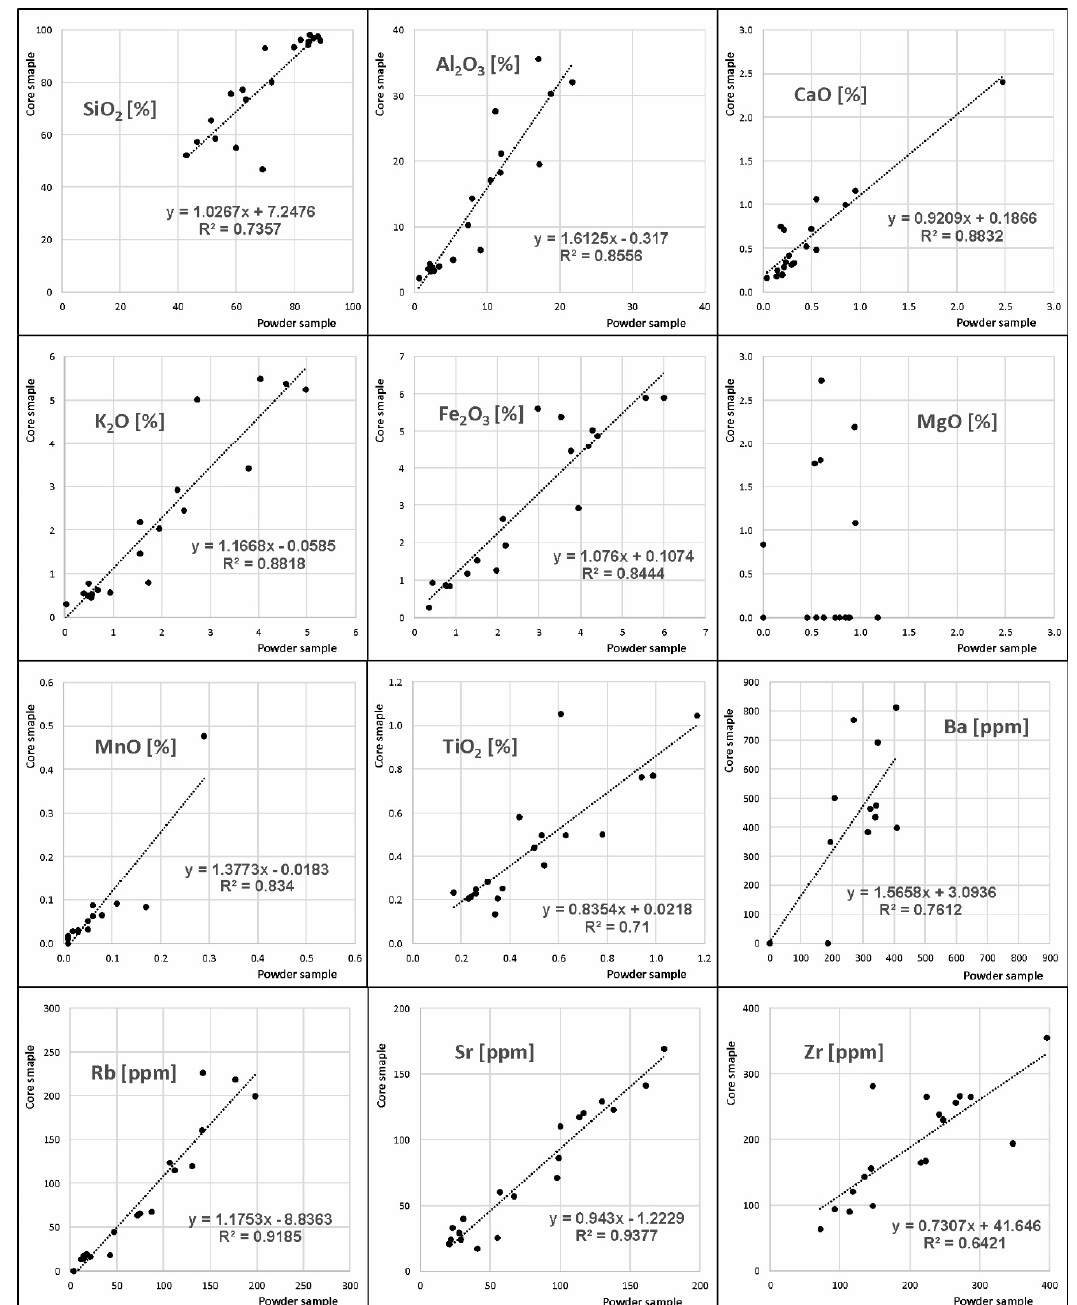
Figure 6. Correlation of chemical composition analysis results obtained in the INIG-PIB on solid and ground samples for the Kobylin-1 borehole.